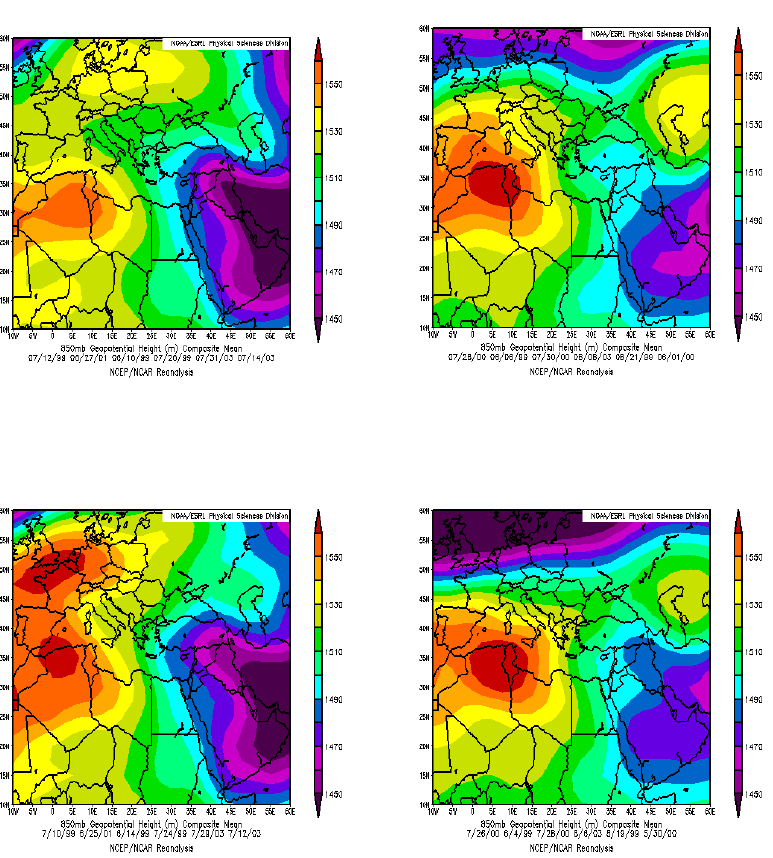
Fig. 11. Composite weather maps of geopotential heights at 850hPa of the 7% of the days with the highest ozone concentrations at the 1500–5000m layer (left column) and of the 7% of the days with the lowest ozone concentrations at the 1500–5000m layer (right column) in Tel Aviv, during the day of the measurement (1st row) and 2-days ago (2nd row). Figure 11. Composite weather maps of geopotential heights at 850 hPa of the 7% of the days 6 with the highest ozone concentrations at the 1500-5000 m layer (left column) and of the 7% of 7 the days with the lowest ozone concentrations at the 1500-5000 m layer (right column) in Tel-8 Aviv, during the day of the measurement (1st row) and 2-days ago (2nd row). 9 10